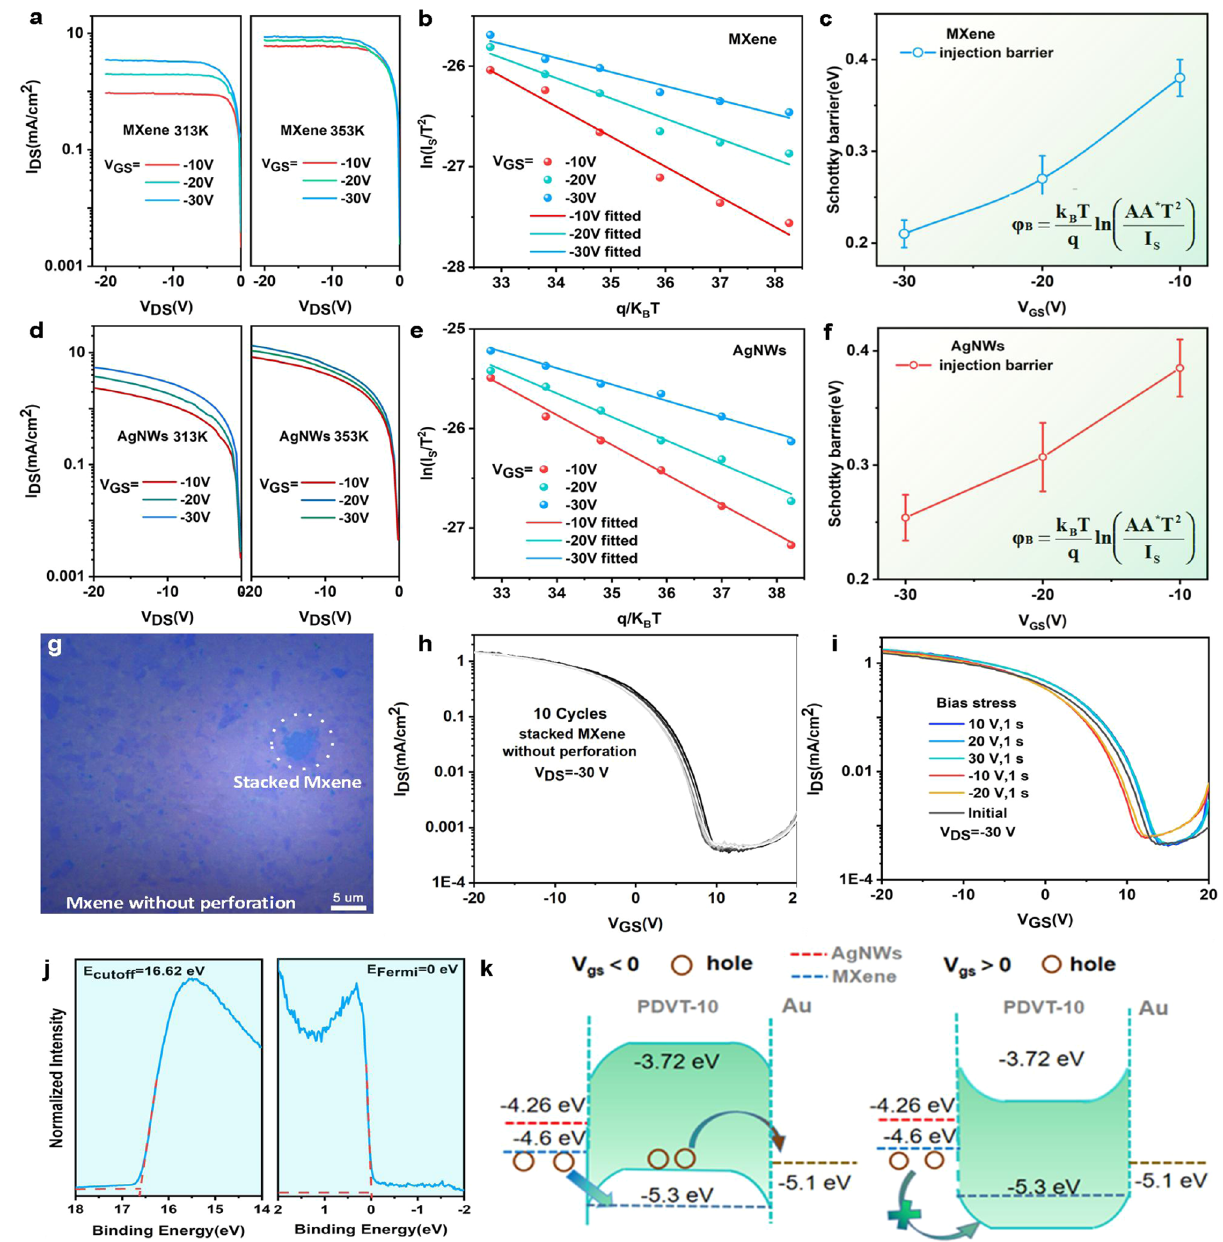
Fig. 3 The working mechanism of MVOFET and AgNWs-based VOFET. a The output characteristic of MVOFET under 313 and 353 K. b ln( I SA T / T 2 ) vs. q /K T plots at various gate voltages. c The variation of Schottky height under different gate voltage. d The output characteristic of AgNWs-based B VOFET under 313 and 353 K. e ln( I SA T / T 2 ) vs. q / K B T plots at various gate voltages of AgNWs-based VOFET. f The variation of Schottky height